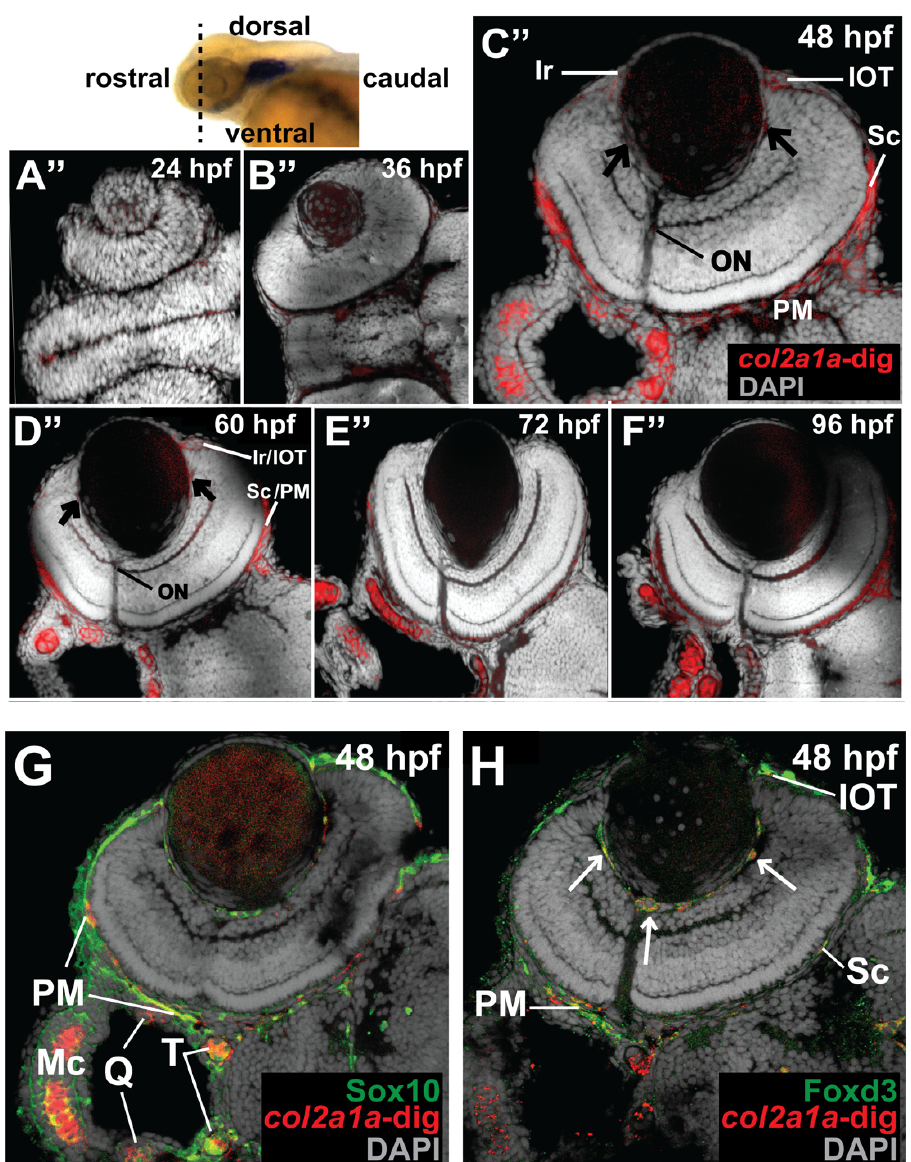
Figure 1. Col2a1a is expressed in the ocular neural crest during early development. Wholemount in situ hybridization in WT Casper ( roy − / − ; nacre − / − ) zebrafish embryos during development at 24, 36, 48, 60, 72 and 96 hpf. Col2a1a gene expression was detected using a colorimetric assay (Vector Blue Substrate Kit, Vector Laboratories) that is both chromogenic (blue) and fluorescent (Far Red/Cy5). The sections were mounted in a media containing DAPI (gray). Lateral ( A – F ) brightfield whole- mount images show that col2a1a expression initiates within the hindbrain (black arrow, ( A ) noto- chord at 24 hpf with dorsoposterior (white arrows, ( B – F )) and ventral (blue arrows, ( B – F )) progres- sion into the ocular and craniofacial expression during eye and jaw development. The yellow arrow ( C ) highlights col2a1a expression in the ocular fissure at 48 hpf. Ventral ( B’ – F’ ) brightfield whole- mount images show col2a1a expression in the developing jaw. The ventral-anterior progression of col2a1a expression is indicated (blue dashed arrows). The red arrows ( D’ ) highlight col2a1a expres- sion in the optic nerve at 60 hpf. By 96 hpf ( F’ ), profound col2a1a expression was detected in the developing jaw and pharyngeal arches (PA). A ventral image of embryonic col2a1a expression at 24 hpf ( A’ ) was not obtained because the embryo is tightly bound to the yolk mass at this stage of development, making it difficult to image the ventral side. Mc, Meckel’s cartilage; pq, palatoquad- rate; ch, ceratohyal; bh, basihyal; hs, hyosympletic. Transverse cephalic sections and fluorescence (FL) microscopy analyses ( A” – F” ) provide additional information for significant ocular col2a1a ex- pression in the anterior segment, with apparent expression in the anterior segment [iris (Ir), iris outflow tract (IOT), hyaloid vasculature (black arrows), sclera (Sc), periocular mesenchyme (PM),